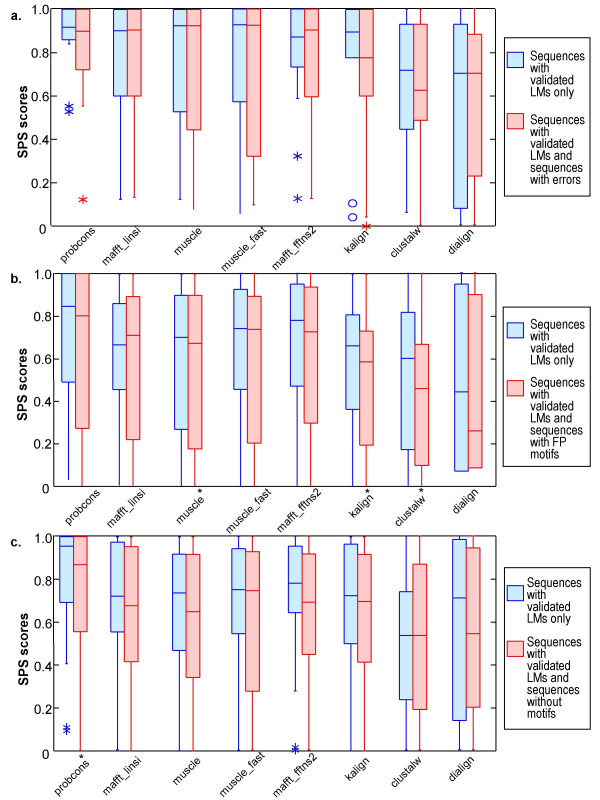
Program SPS scores after inclusion of sequences without validated motifs. Box plots of the SPS scores obtained by the different alignment programs under different conditions, showing the extreme observations (stars or circles), lower quartile, median, upper quartile, and largest observation. Significant differences, according to a Wilcoxon signed ranks test (p < 0.05), are indicated by an asterix on the x-axis. P-values for the Wilcoxon tests are available in additional file 1, table 3. a) SPS scores for alignments of sequences with validated motifs only compared to alignments including sequences with errors. b) SPS scores for alignments of sequences with validated motifs only compared to alignments including sequences containing false positive (FP) motifs. c) SPS scores for alignments of sequences with validated motifs only compared to alignments including sequences that do not contain any examples of the motif.